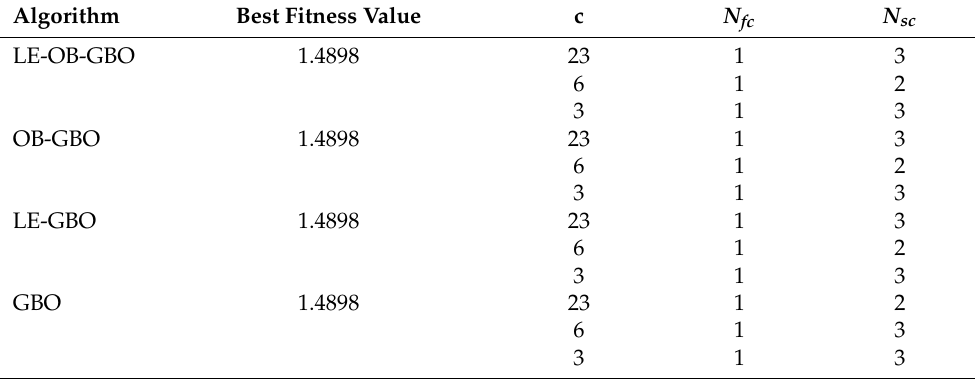
Table 7. Optimal placement of the charging station—case 3.